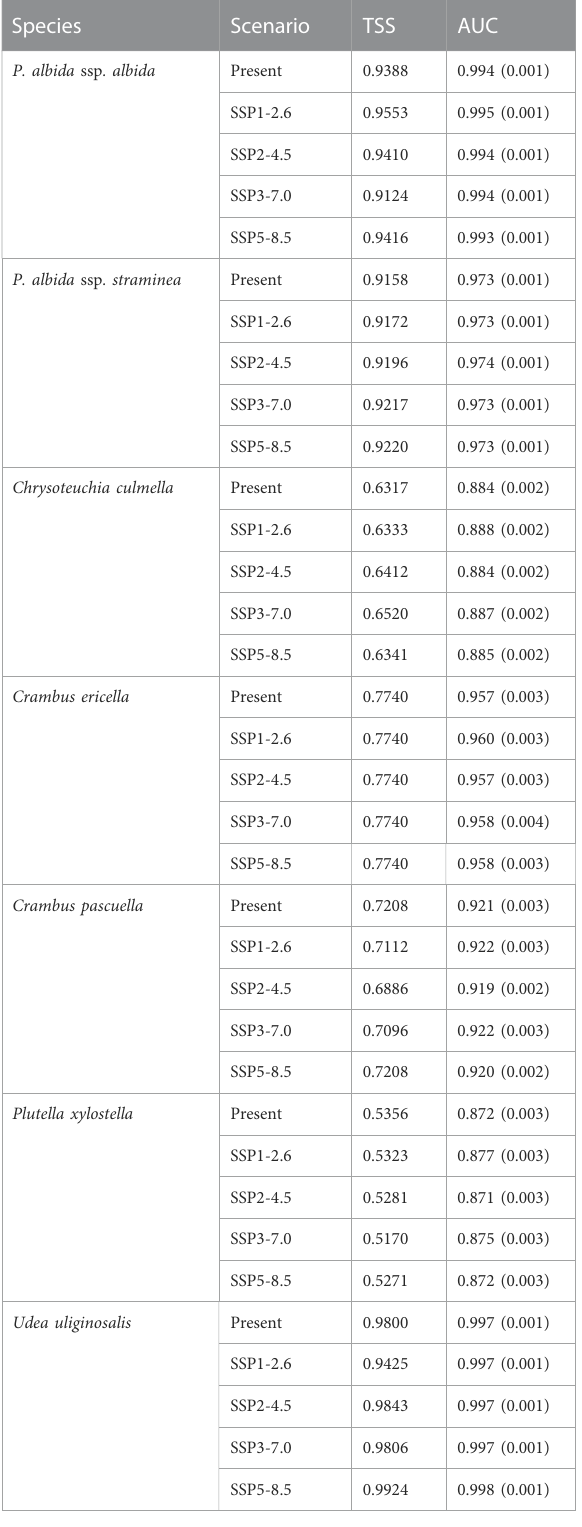
TABLE 2 TSS scores, average training AUC, and standard deviations (in brackets) for the replicate runs of the